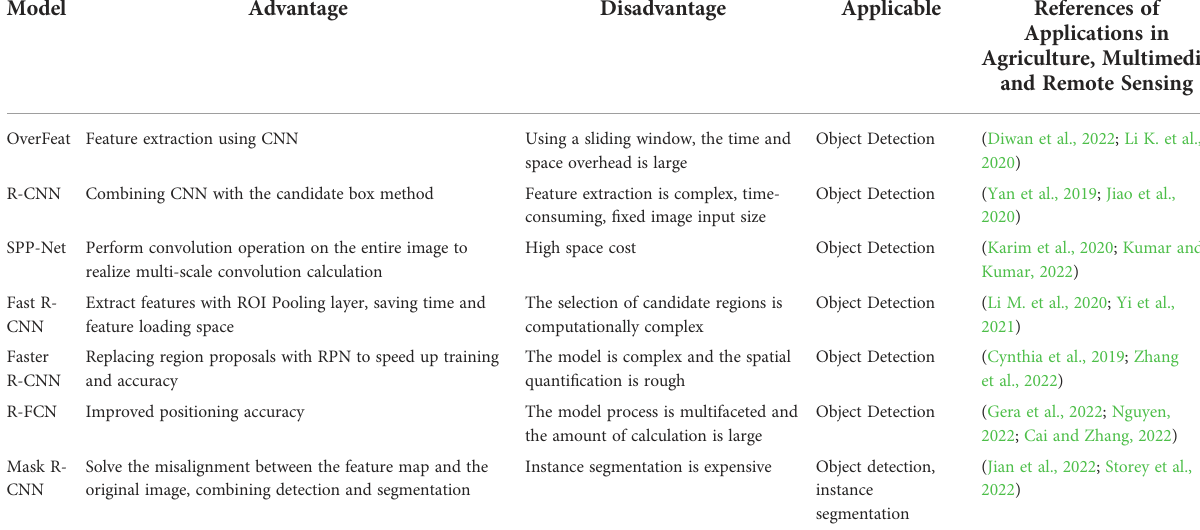
TABLE 2 Advantages, disadvantages, and applicable scenarios of two-stage Object detection algorithms.